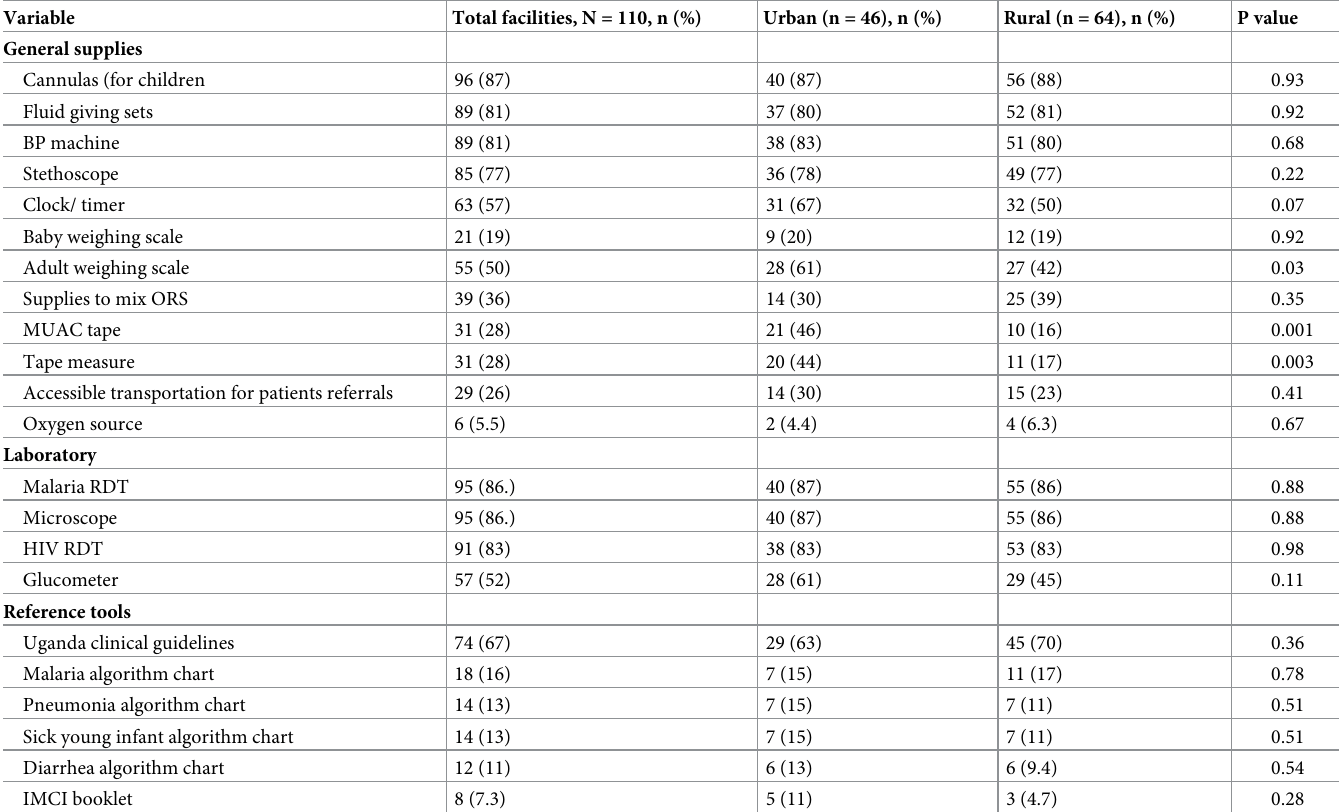
Table 4. Availability of medical supplies and equipment in LLPHFs in Mbarara district, Uganda by location of the